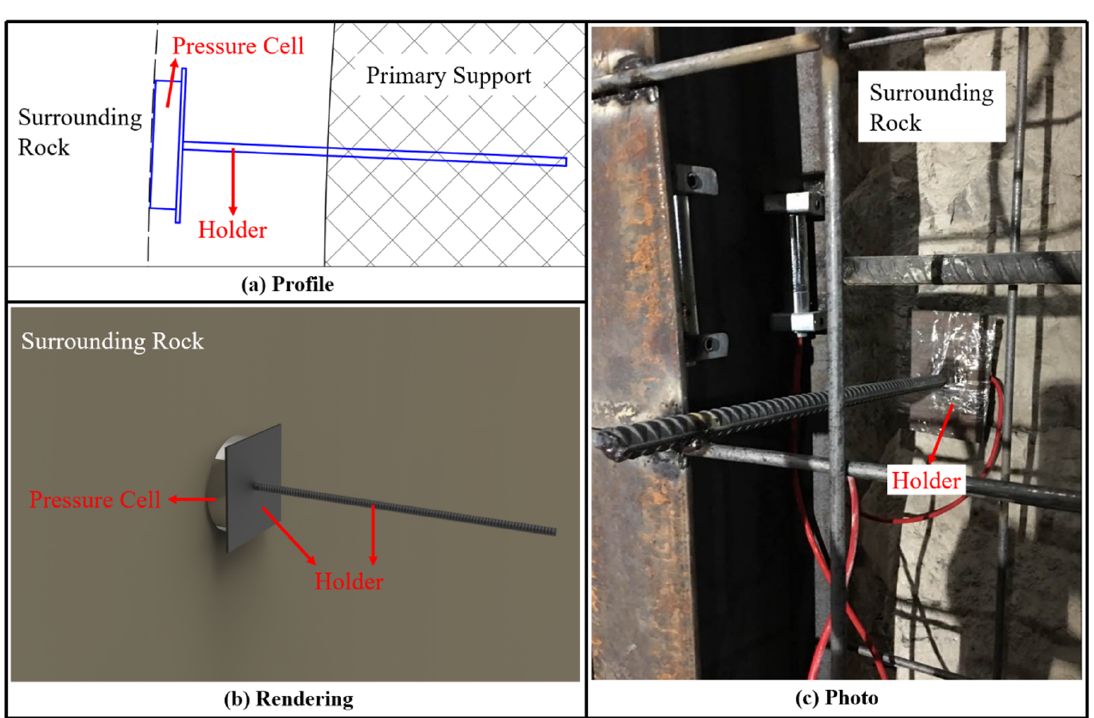
Figure 7. Pressure cells between surrounding rock and primary support. By these cells, the total pressure of the primary support and secondary lining can be measured.